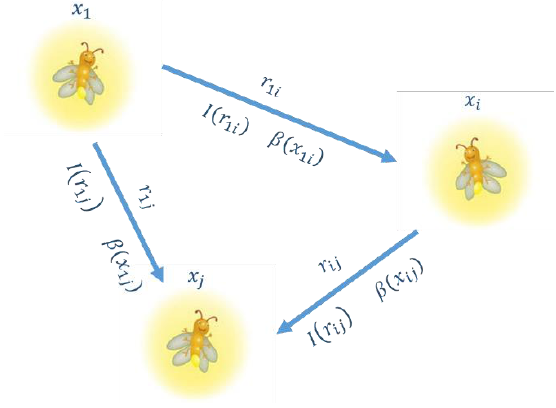
Figure 3. A conceptual view of the firefly algorithm relationships, including locations 𝑥 , distance 𝑟 , brightness 𝐼(𝑟) , and attractiveness 𝛽(𝑟) .